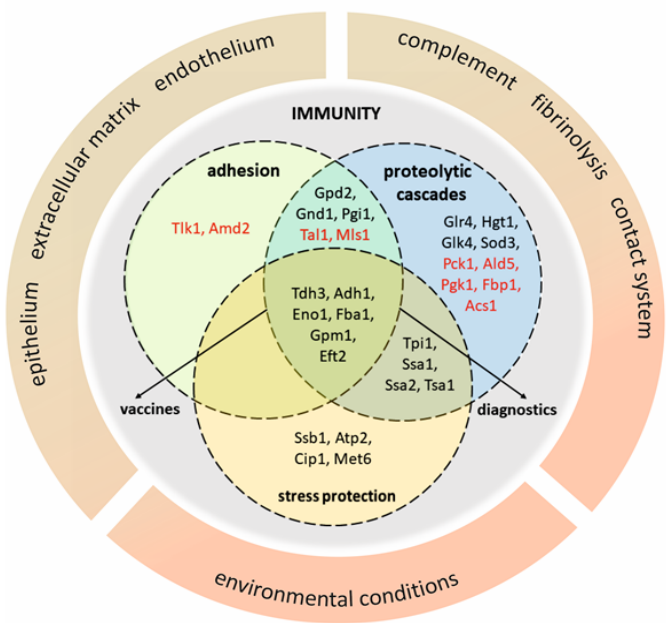
Figure 2. Diagram that groups moonlighting proteins on the basis of their involvement in adhesion to host cells and extracellular matrix proteins, activation of homeostatic / hemostatic proteolytic cascades and protection against stressful environmental conditions. The broad specificity actions are illustrated by the overlap of various functions performed by individual proteins, whilst the presence of at least several proteins in each circle emphasizes the collective action of moonlighting proteins that may be potential vaccine or diagnostic targets. Symbols of C. albicans moonlighting proteins are enriched with selected homologues of non-albicans Candida species (red font).